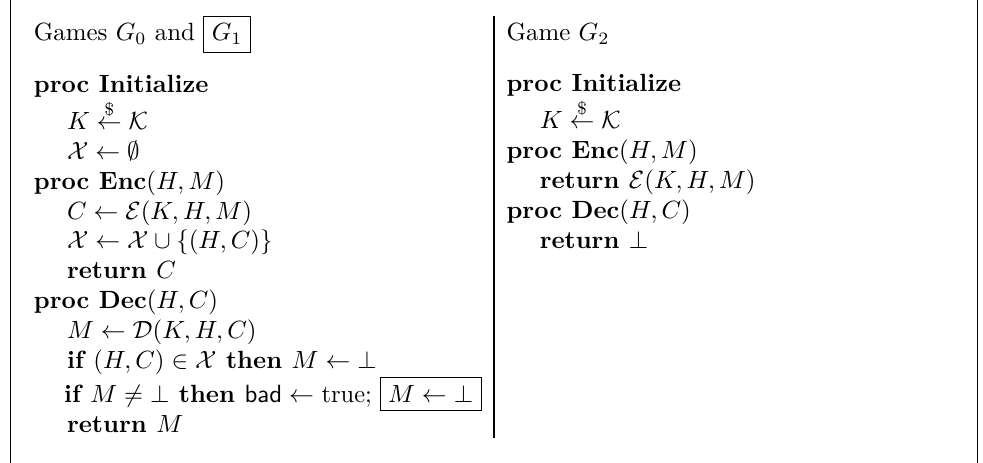
Figure 11: Games G 0 , G 1 (left) and G 2 (right) for the reduction of B-INT-CTXT . The boxed statement is present in game G 1